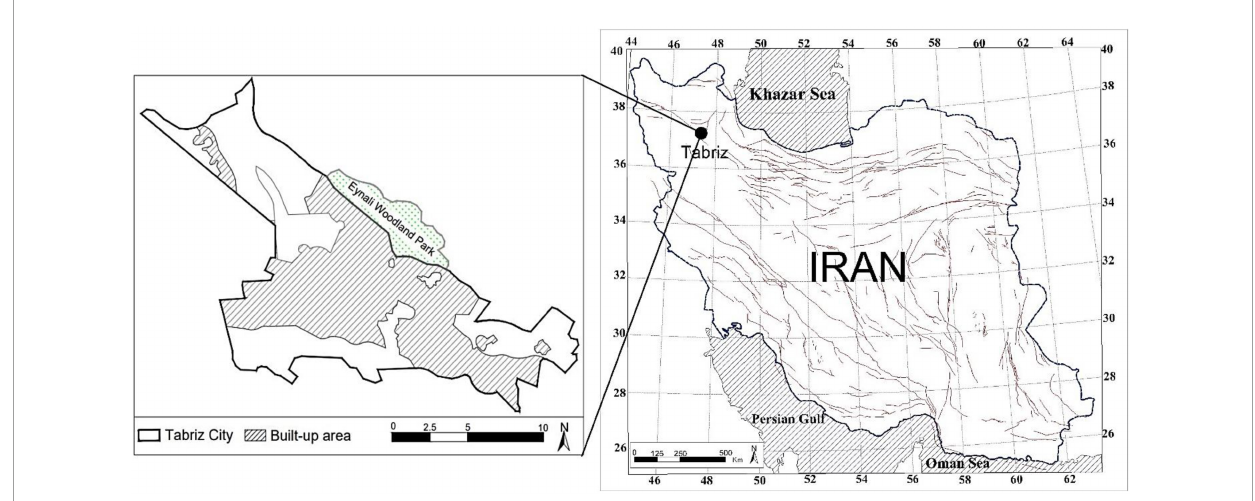
FIGURE1 Two locations of Tabriz in Iran and Eynali woodland park in Tabriz (own design by the authors).